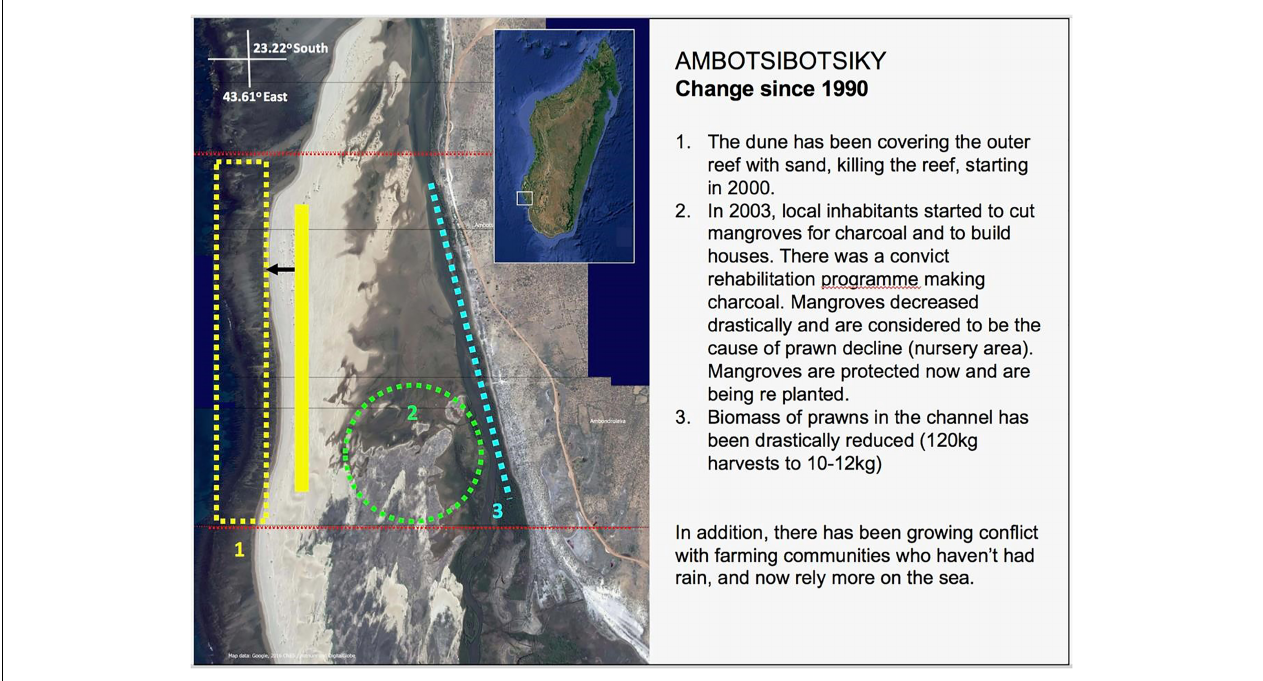
FIGURE 5 | Perceptions of change since 1990 as report by Ambotsibotsiky community members. TABLE 2 | Anticipated repercussions of future drought on Malagasy coastal communities and suggestions as to what can be done to mitigate these effects. Scenario: Increasing